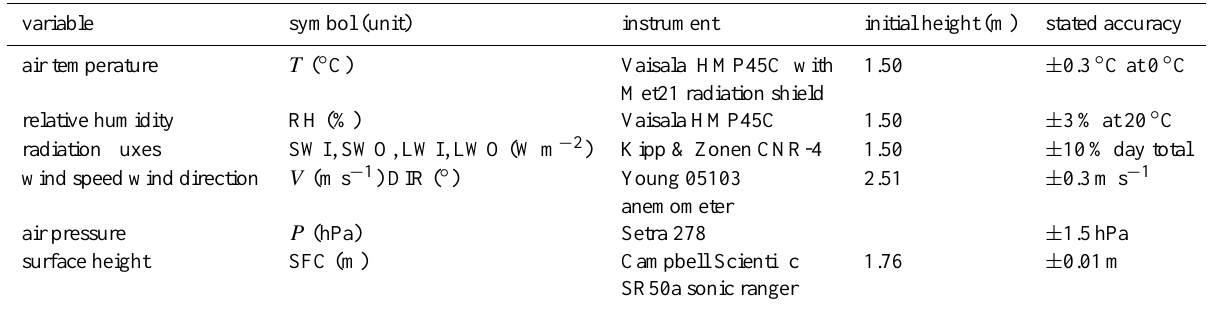
surface height SFC